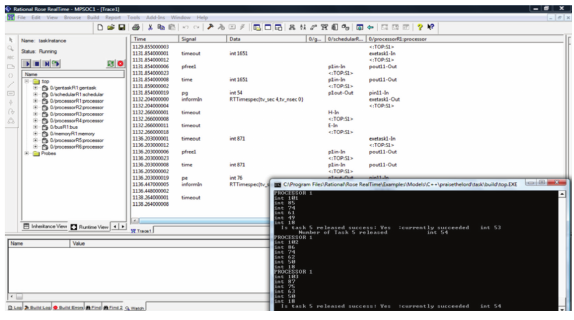
Figure 13: Simulation result in